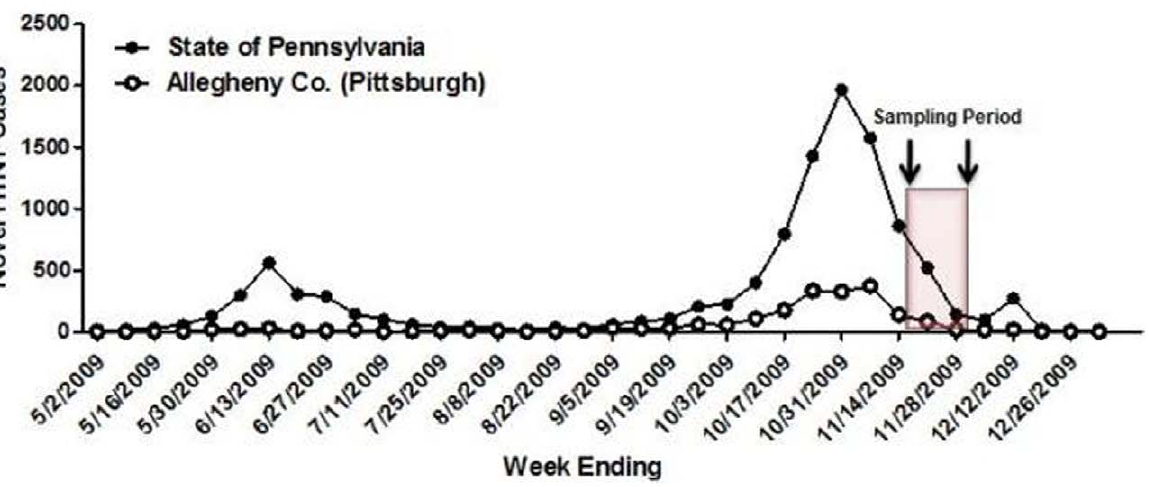
Figure 1. Allegheny County, Pennsylvania pandemic H1N1 cases. Sampling period for serosurvey (November 16-December 4, 2009) shown relative to epidemic curve. Distribution of the novel H1N1 vaccine to health clinics began in late-November.